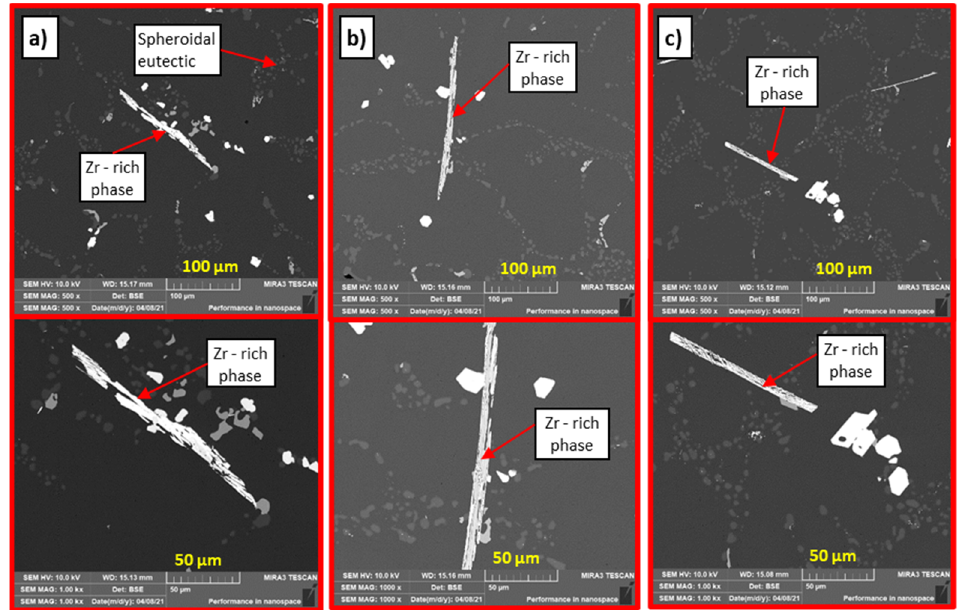
Figure 10. Microstructure of experimental alloys, H 2 SO 4 etch., ( a ) alloy F1 0.1 wt. % Ti after heat treatment, ( b ) alloy F2 0.2 wt. % Ti after heat treatment, and ( c ) alloy F3 0.3 wt. % Ti after heat treatment.